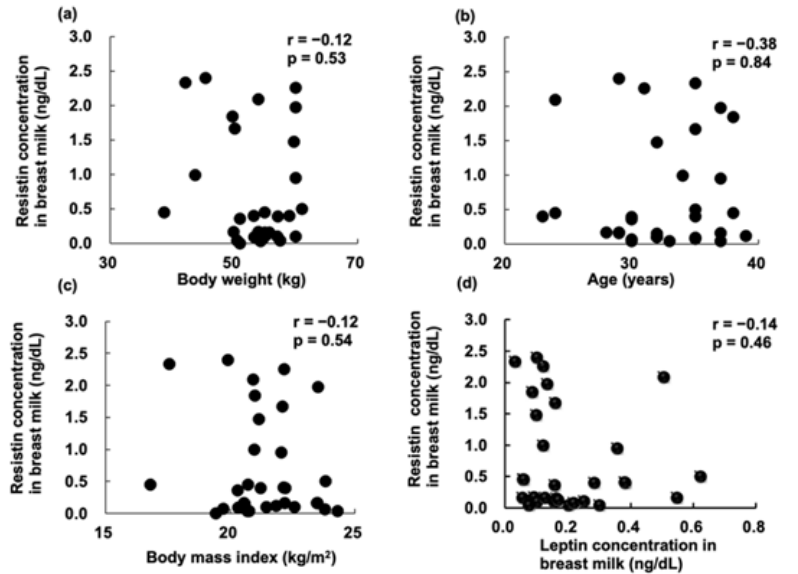
Figure 4. Correlation between resistin concentration in the breast milk and ( a ) body weight; ( b ) age; ( c ) body mass index (BMI); and ( d ) leptin concentration in mothers’ breast milk at 1 month post ‐ partum.